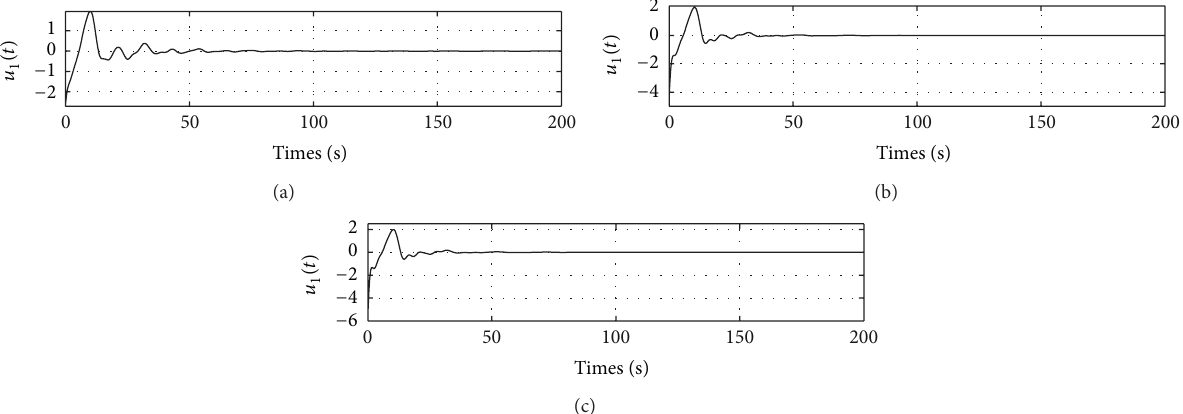
Figure 10: Effect of the number of prediction points on the control inputs: (a) Case 1 ( 𝑁 = 5 ), (b) Case 2 ( 𝑁 = 10 ), and (c) Case 3 ( 𝑁 = 15 ).